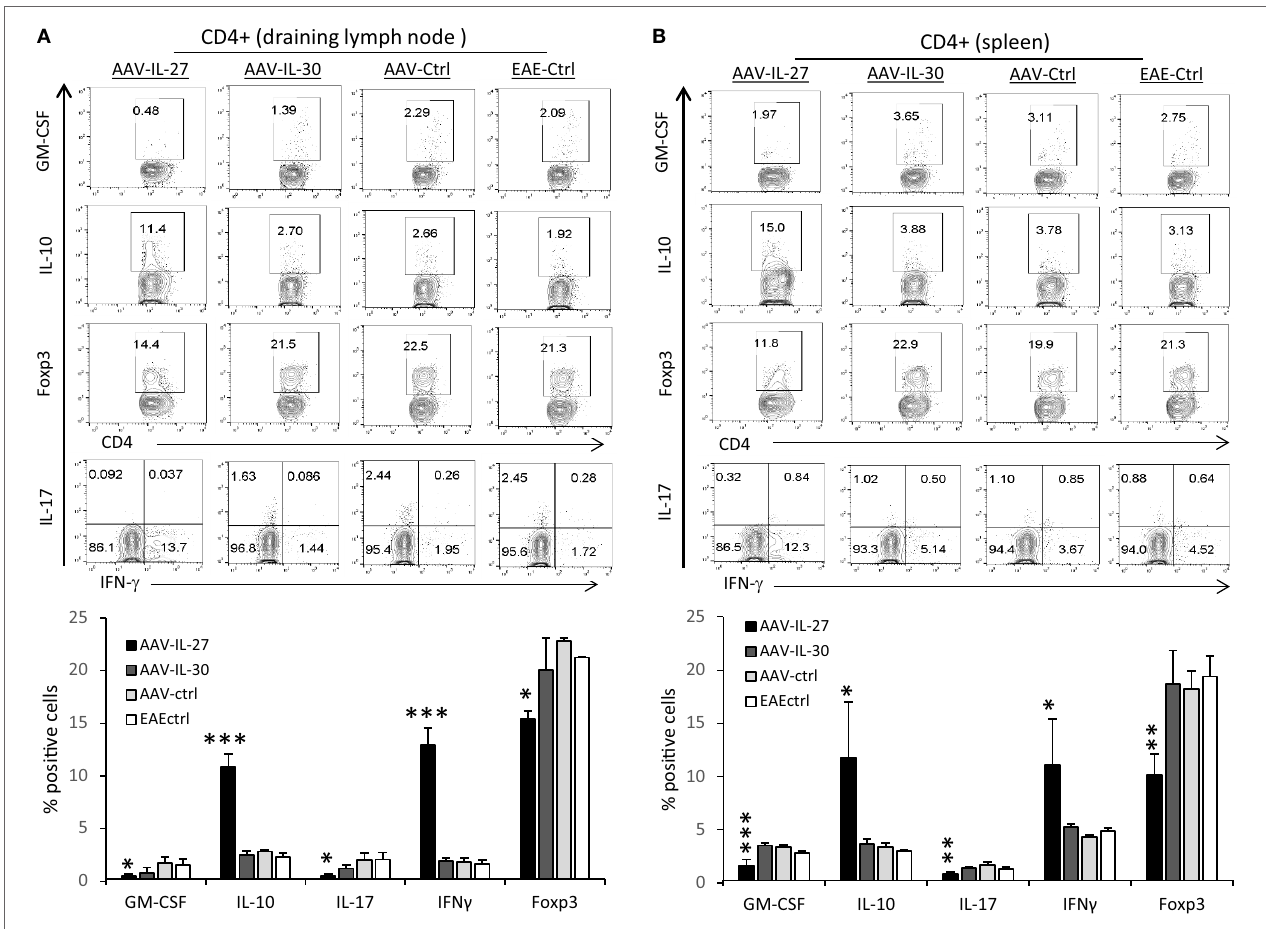
FigUre 3 | T cell subsets in mice whose experimental autoimmune encephalomyelitis (EAE) development was prevented by adeno-associated viral vector (AAV)-delivered interleukin-27 (IL-27). C57BL6 mice ( n = 5/group) were treated with AAV-IL-27, AAV-IL-30, and AAV-ctrl virus i.m. at a dose of 2 × 10 11 DRP/mouse or left untreated. One week later, the mice were induced for EAE and sacrificed 2 weeks after EAE induction. T cell subsets in draining lymph nodes (a) and spleens (B) were analyzed by flow cytometry. Data were summarized and presented in the lower panels. * P < 0.05; ** P < 0.01; *** P < 0.001 by one way ANOVA. Data shown represent two experiments with similar